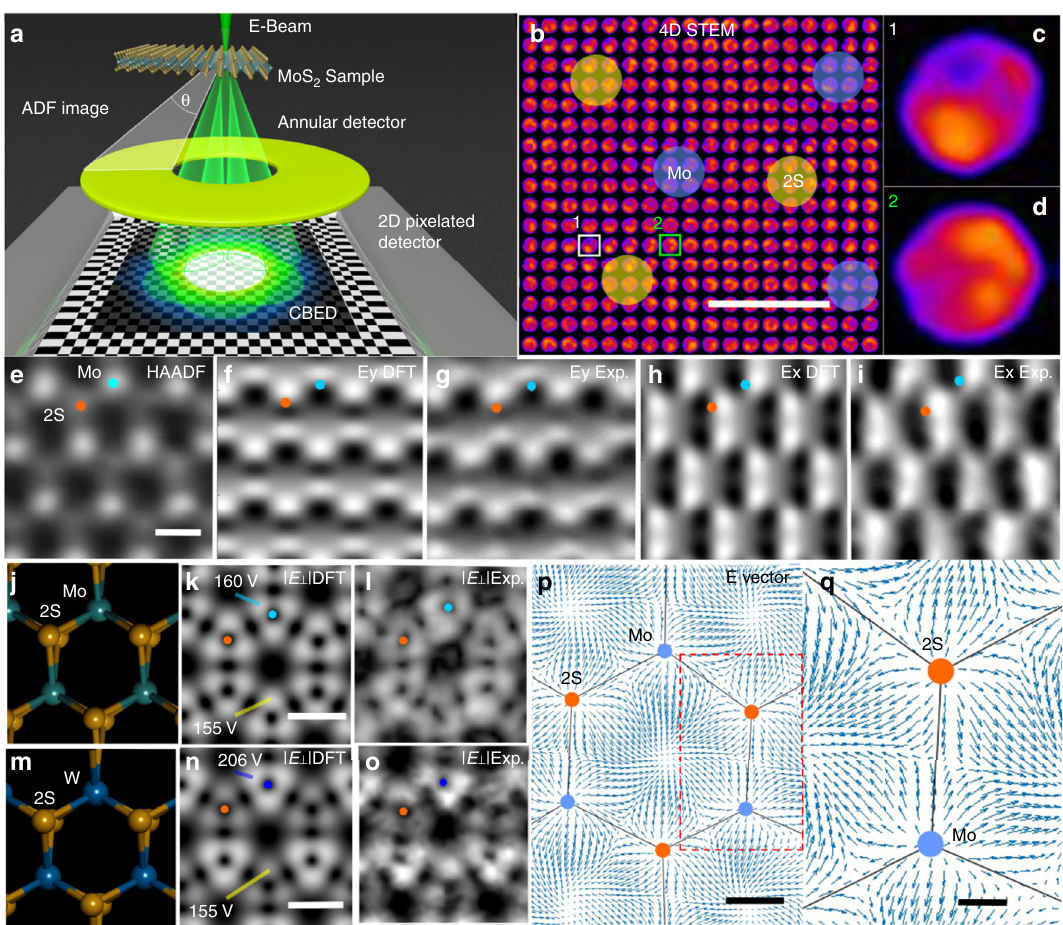
Fig. 1 Atomic resolution 4D STEM of pristine MoS 2 and WS 2 . a Schematic illustration of the 4D STEM geometry used. b 4D STEM data plotted as montage of CBED patterns, showing variations as a function of probe position relative to Mo and 2S atom positions. Scale bar indicates 0.2 nm. c CBED pattern from the position marked with the white box 1 in b , and d CBED pattern from the position marked with the green box in b . e HAADF-STEM image of MoS 2 taken using the ADF detector. Scale bar indicates 0.2 nm. f DFT-calculated E ┴ y fi eld around MoS 2 . g Experimental E ┴ y fi eld around MoS 2 measured from I com y , normalized and scaled to the range matching the DFT values. h DFT-calculated E ┴ x fi eld around MoS 2 . i Experimental E ┴ x fi eld around MoS 2 measured from I com x , scaled to the range matching the DFT values. j Atomic model of MoS 2 in a tilted projection to show 2S column. k DFT calculated | E ┴ | around MoS 2 , according to the atomic model in ( j ). Scale bar indicates 0.2 nm. l Experimental | E ┴ | around MoS 2 measured from the I com , scaled to the range matching the DFT data. m Atomic model of WS 2 in a tilted projection to show 2S column. n DFT calculated | E ┴ | around WS 2 , according to the atomic model in m . Scale bar indicates 0.2 nm. o Experimental | E ┴ | around WS 2 measured from I com , scaled to the range matching the DFT data. Orange dots in e − n indicate S atoms position, cyan dots represent Mo and blue dots W. p 2D map of the E ┴ vector, from the I com vector, in arrow representation (arrow size indicates the magnitude of vector) around the MoS 2 lattice. Scale bar indicates 0.1 nm. q Magni fi ed view from the red dashed boxed area in p showing a high-resolution E ┴ vector plot around a single Mo atom and 2S column. Scale bar indicates 0.05 common and simplest observed (Fig. 2b and supplementary embedded within the 2D lattice, where S depletion is greatest. fi gure 4). The tilt and in-plane bond compression make it hard DFT calculations of the electron charge density maps (Fig. 2h, i) to fully resolve this 2SVL using ADF-STEM imaging (Fig. 2c and show a small increase in electron density in this area compared supplementary fi gure 5). The ptychographic reconstructed phase to the center of the hexagonal lattice (Fig. 2i). Figure 2i is the (Fig. 2d) has higher resolution but is sensitive to height same image as Fig. 2h, but with the scale replotted to truncate fl uctuations 21,22 . The | E the z -axis scale to 10 Å − 2 , whereas in Fig. 2h it is 20 Å − 2 . This ┴ | map (Fig. 2e) has high sensitivity to local bonding coordination and can enable full structure deter- rescaling helps to see the contrast from the 1D channel area. mination of the 2SVL. The DFT calculations predicted a similar | Similar results are obtained for the 2SVL in WS 2 monolayers (Fig. 2j – m), where the W − W bonding also provides the E ┴ | image (Fig. 2f) based on the model in Fig. 2b. The vector negative-rich 1D channels. The E ┴ images for MoS 2 and WS 2 map of E ┴ around the 1D channel is shown in supplementary fi gure 6. An atomic resolution image of the total charge is both show distinct pro fi les for the metal atoms located in the produced from the divergence of the E ┴ (Fig. 2g) revealing 2SVL channel, which are shown in more detail in Fig. 3. DFT regions that are negative rich (blue) and positive rich (red). The calculations of the in-gap states, supplementary fi gure 7, for the 2SVL are shown in Fig. 2n, o, with localization at the 1D channel regions with positive-rich charge are localized around the nuclei in the same region. These results con fi rm the experimental due to the protons, while the negative-rich regions are at the imaging of 1D conduction channels that match the theoretically center of the hexagons and in the 2SVL 1D channels. The latter prediction location. gives rise to a 1D atomically con fi ned negative-rich channel